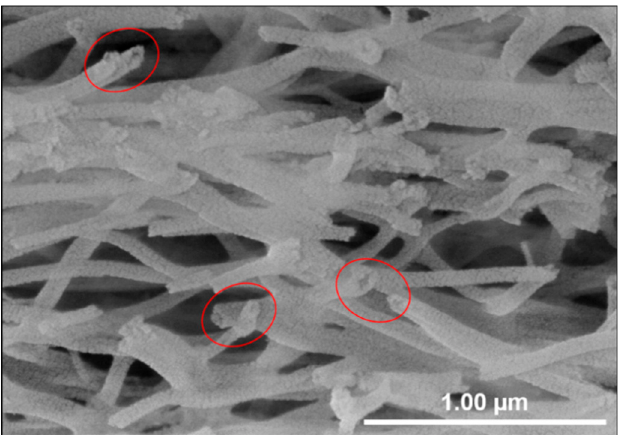
Figure 9. SEM images of CuCrO 2 hollow nanotubes after removal of Al 2 O 3 core and impurities by 2M H 2 SO 4 for 2 days and DI water.